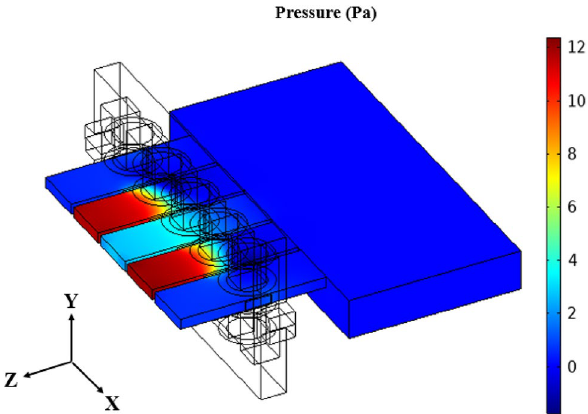
Fig. 15 The pressure variations of the active arrays number 2 and 4 in the opposite directions